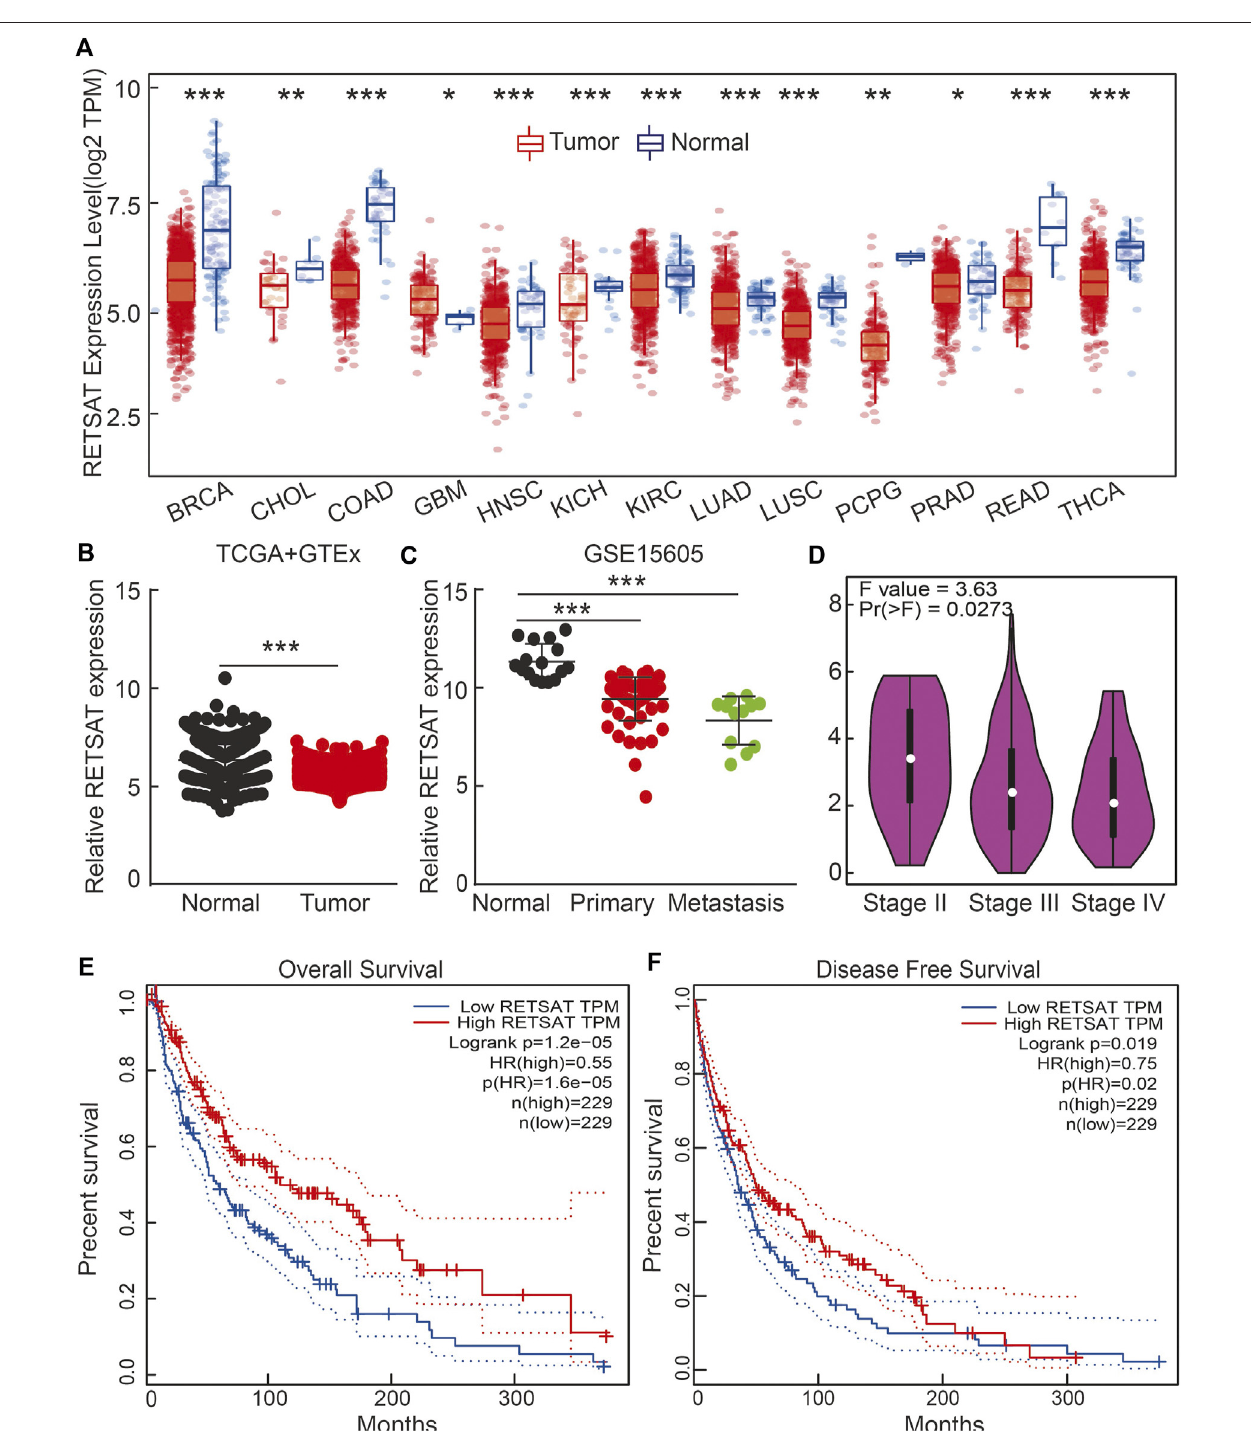
FIGURE1| RETSAT expression patterns inhuman cancers. (A) RETSAT expression ofdifferenttypes ofhuman cancers usingthe TIMER database.Red: tumors; blue: normal tissues. (B) The expression pattern of RETSAT, comparing the pro fi les from SKCM in (TCGA) and GTEx (Genotype-Tissue Expression, mostly for normal tissues). (C,D) Theexpression patternsofRETSATinSKCM using theGEOdatabasesandtheGEPIA database (D) . (E) The overallsurvival(OS:E)and thedisease-free survival (DFS: F) tests for RETSAT in SKCM in GEPIA database. * p < 0.05, ** p < 0.01, *** p < 0.001.